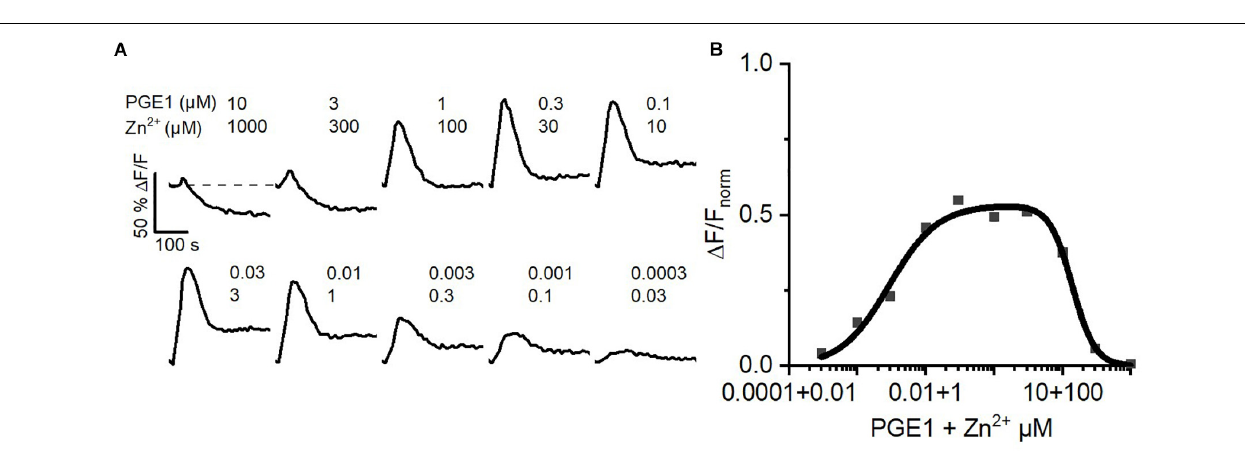
FIGURE 7 | Ca 2 + signals evoked by dilute solutions of a Zn 2 + /PGE 1 mixture. (A) Representative Ca 2 + signals in human sperm stimulated with a serially diluted mixture of 10 µ M PGE 1 and 1 mM Zn 2 + . (B) Concentration–response relationship for the maximal amplitudes of Ca 2 + signals shown in (A) relative to that evoked by PGE 1 (3 µ M) in the absence of Zn 2 + (set to